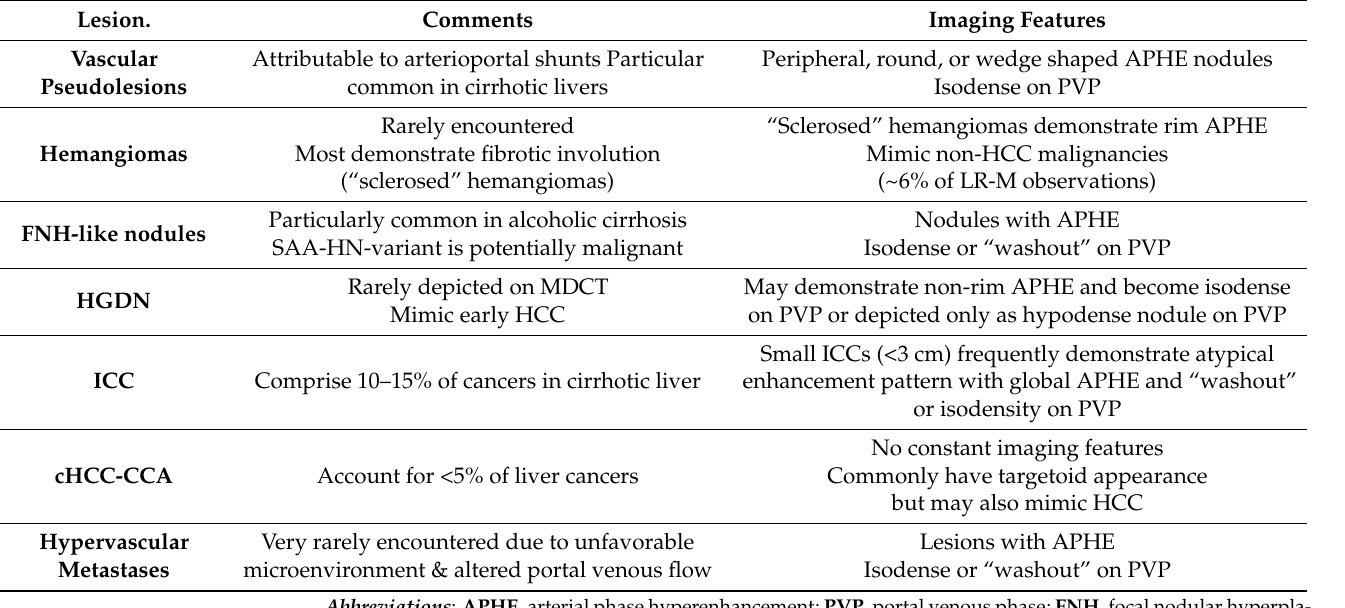
Table 5. Hypervascular HCC mimickers in patients with cirrhosis or chronic liver disease [54,57–61].